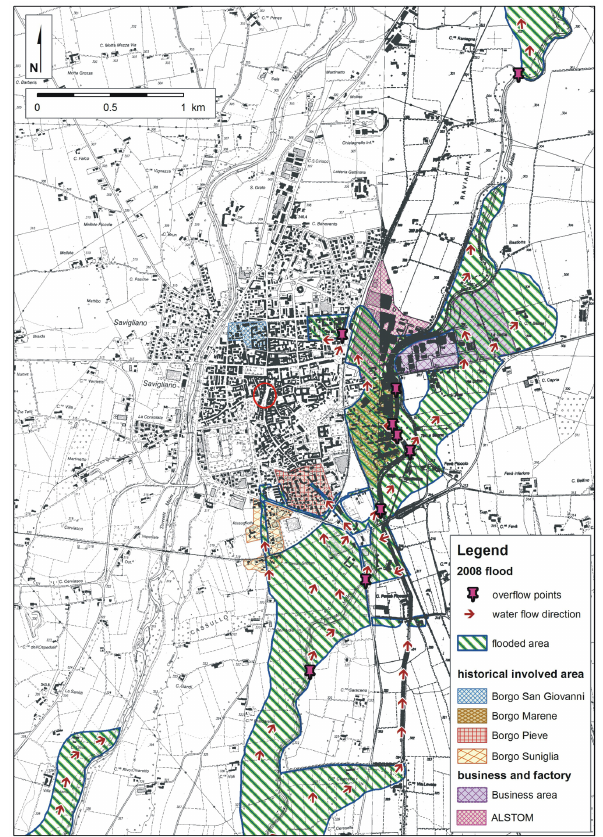
Fig. 3. Flooded area in May 2008 event (oblique green and blue lines). In the map the districts usually affected by flood are indi- cated (Borgo San Giovanni, Borgo Marene, Borgo Pieve, and Borgo Suniglia). The locations of the main factory and the business area are indicated too. In the red circle, the square flooded in Fig. 7a and b. In background the Technical Regional map, 1991